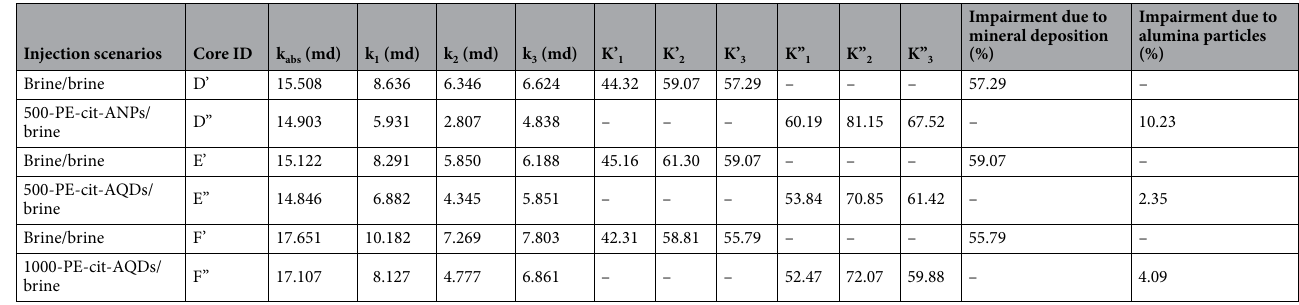
Table 3. Permeability reduction of core plug samples during fluid flooding and impairment behavior due to mineral deposition and nanoparticles.